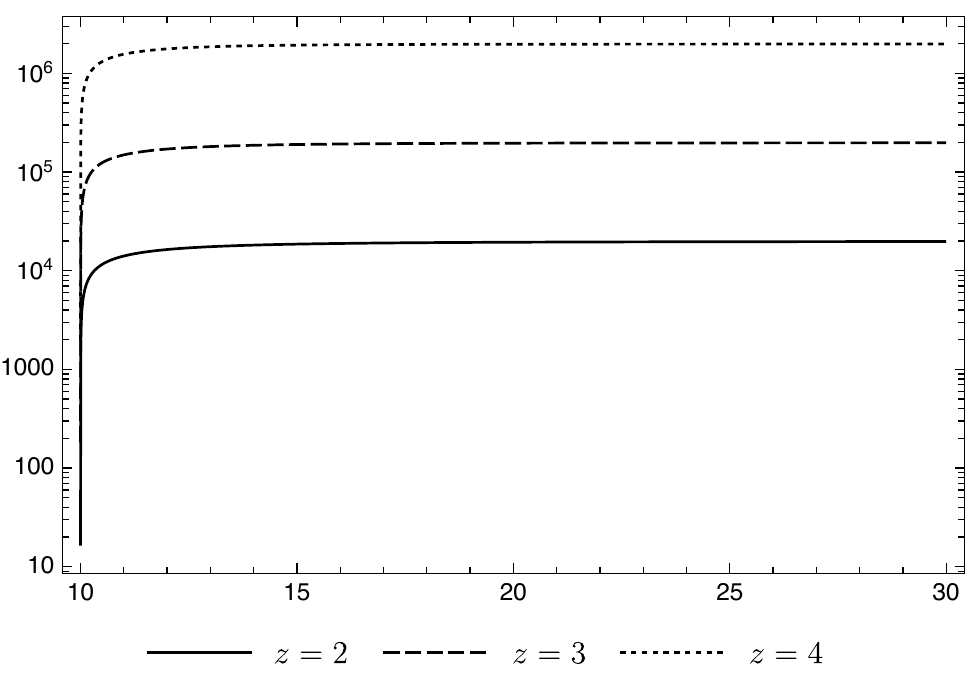
Figure 3 . The energy of a black holes with R 0 = 10 . Figure shows the energy for different cases with z = 2 , 3 , 4 .